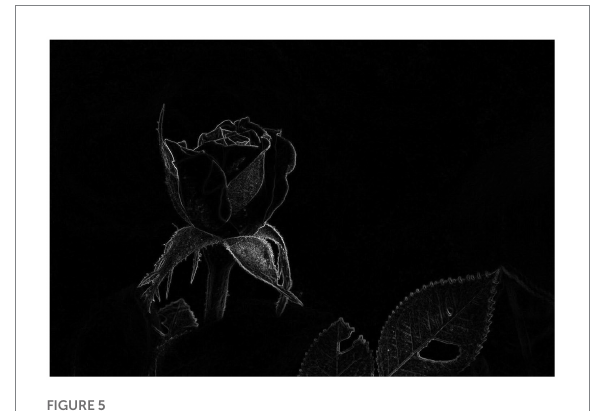
FIGURE 5 Example of extracting image